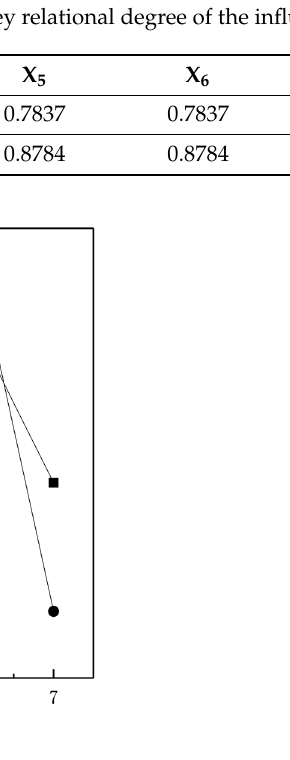
Figure 9. The weighted grey relational degree and fuzzy grey relational degree line chart of the influencing factors.